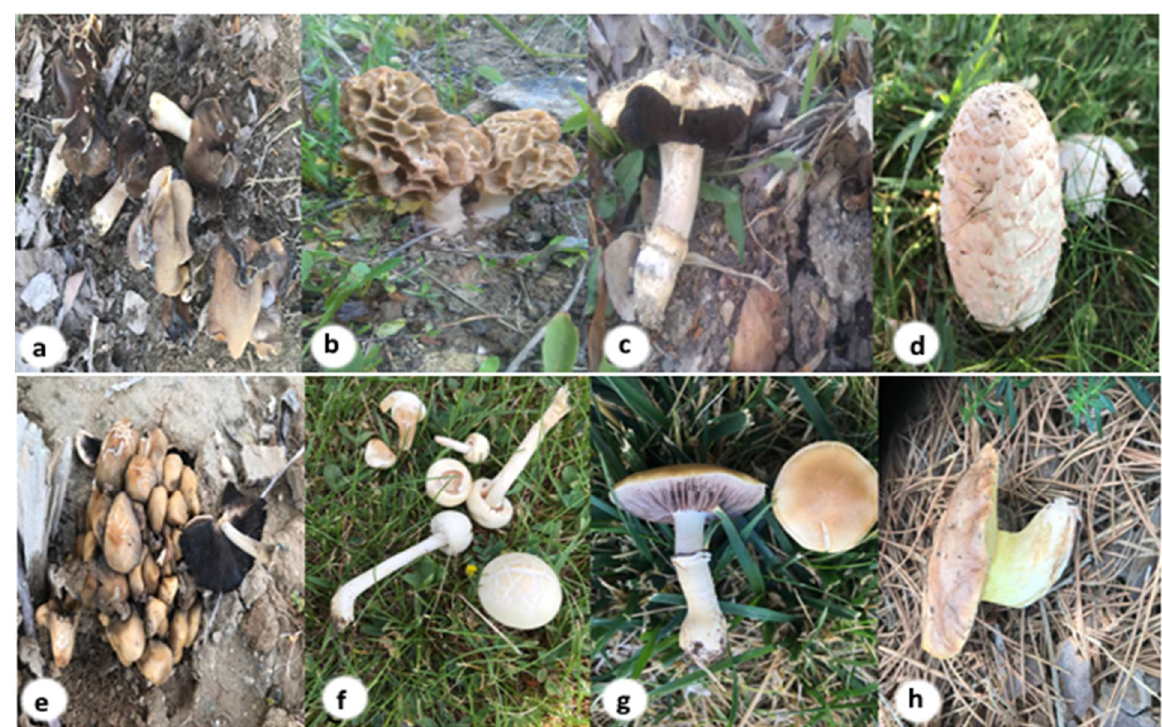
Figure 1. General view of all mushrooms collected: ( a ) Helvella leucopus, ( b ) Morchella esculenta, ( c ) Agaricus bitorquis, ( d ) Coprinus comatus, ( e ) Coprinellus micaceus, ( f ) Agrocybe dura, ( g ) Psilocybe coronilla, ( h ) Suillus collinitus .